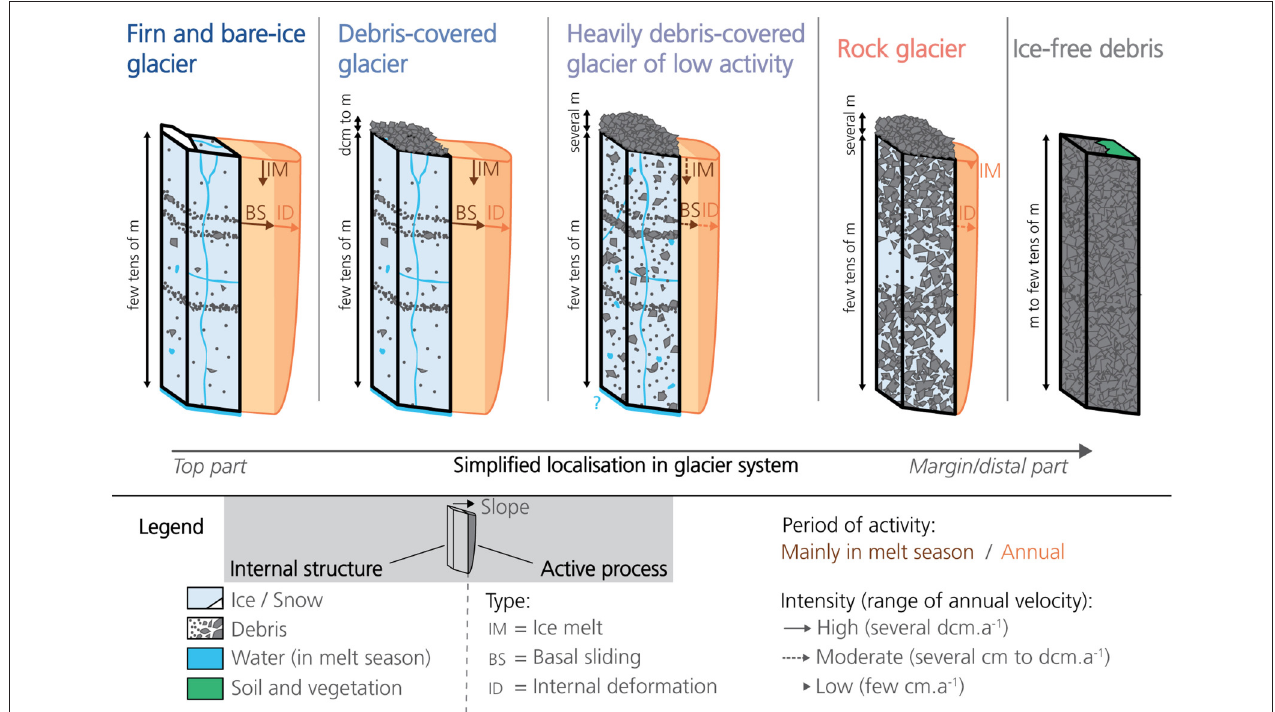
FIGURE 9 | Schematic diagrams showing the internal structure characteristics and the main dynamics occurring in the five main zones of les Rognes, Tsarmine and Entre la Reille